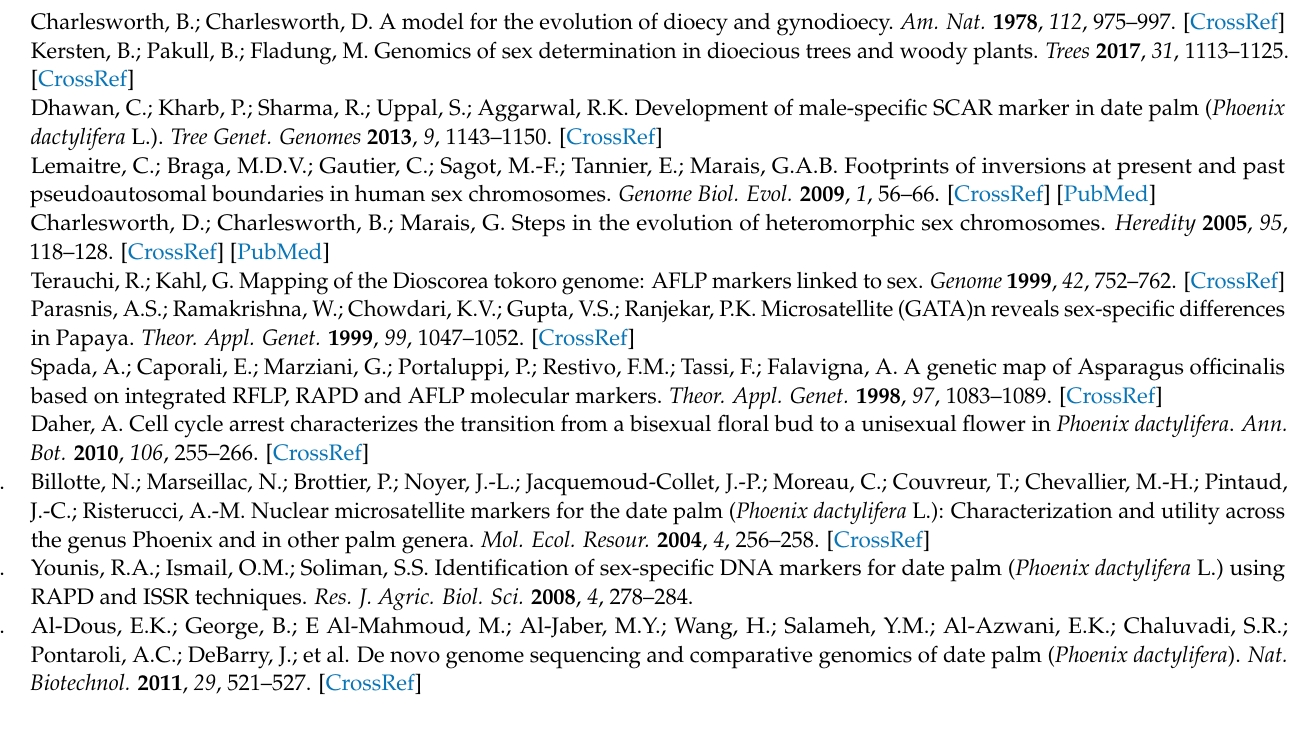
7/10/3/536/s1, Figure S1: NIR spectra (without pre-processing) of male (A) and female immature date palm leaf samples, Figure S2: PCA model loading plot of the NIR spectral data of both male and female immature date palm leaf samples, Figure S3: PLS-DA score plot using the NIR spectral data of male and female date palm leaf extract samples, Figure S4: PLS-DA loading plot using the NIR spectral data of male and female date palm leaf extract samples, Figure S5: PLS-DA loading plot using the NIR spectral data of male and female date palm leaf extract samples, Figure S6: PCA Loading plot using FTIR ATR spectral data of male and female date palm leaf samples, Figure S7: PCA plot for PLS-DA using FTIR ATR spectral data of male and female date palm leaf samples, Figure S8: PLS-DA loading plot using FTIR ATR spectral data of male and female date palm leaf samples, Figure S9: PCA model loading plot of the NMR spectral data of both male and female date palm leaf extract samples, Figure S10: NIRS of unknown samples at immature stage of date palm, Figure S11: PLS-DA plot using NIRS spectral data for unknown samples at immature stage of date palm, Table S1: Primers used for identifying the gender specific traits in date palm samples, Table S2: Estimated allele frequencies and estimated heterozygosity and other analyses for all